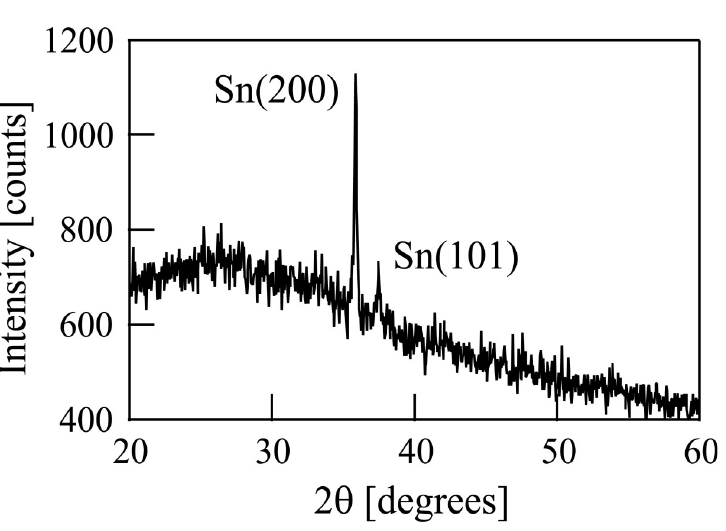
Fig 7. X-ray diffraction pattern of the film deposited on a Si substrate following the irradiation of Sn + ions produced from tetramethyltin.